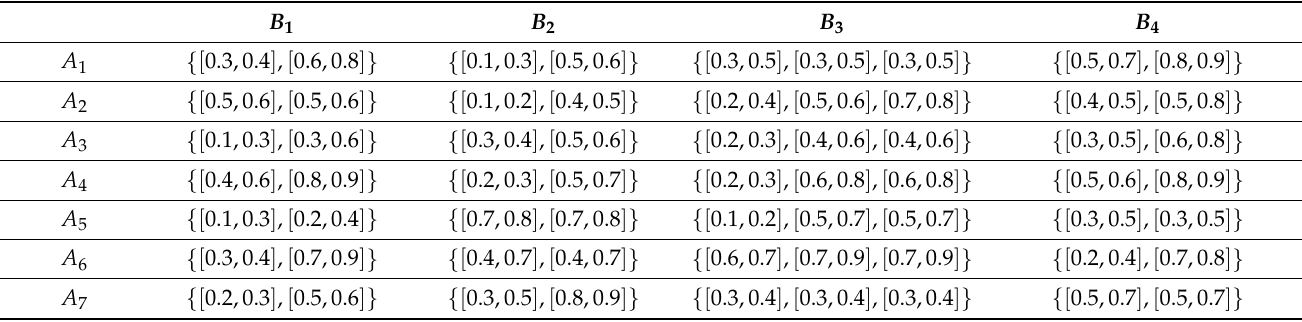
Table 4. Interval-valued hesitant fuzzy preference matrix